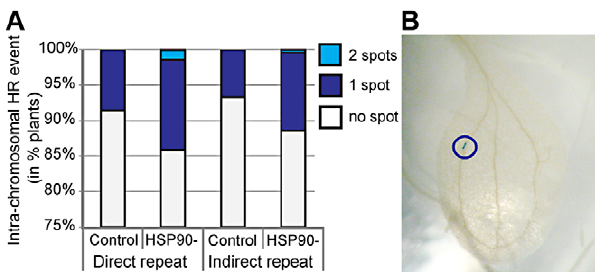
Figure 1. HSP90 inhibition increases homologous recombina- tion in plants. (A) Transgenic plants carrying reporter constructs that monitor somatic homologous recombination (HR) events [48] were grown with and without HSP90 inhibition. HR restores a functional GUS gene, allowing for detection of somatic HR events. Intra-chromosomal HR events were significantly increased in plants grown with the HSP90 inhibitor geldanamycin for direct and indirect repeat reporter constructs (Poisson regression p =0.0078). A total of 925 seedlings were analyzed with 381 seedlings for the direct repeat reporter line and 544 for the indirect repeat reporter line. (B) Example of somatic HR event in plant leaf (blue circle around GUS spot) (unpublished data by K. Carlson, A. Nuttle, and C.